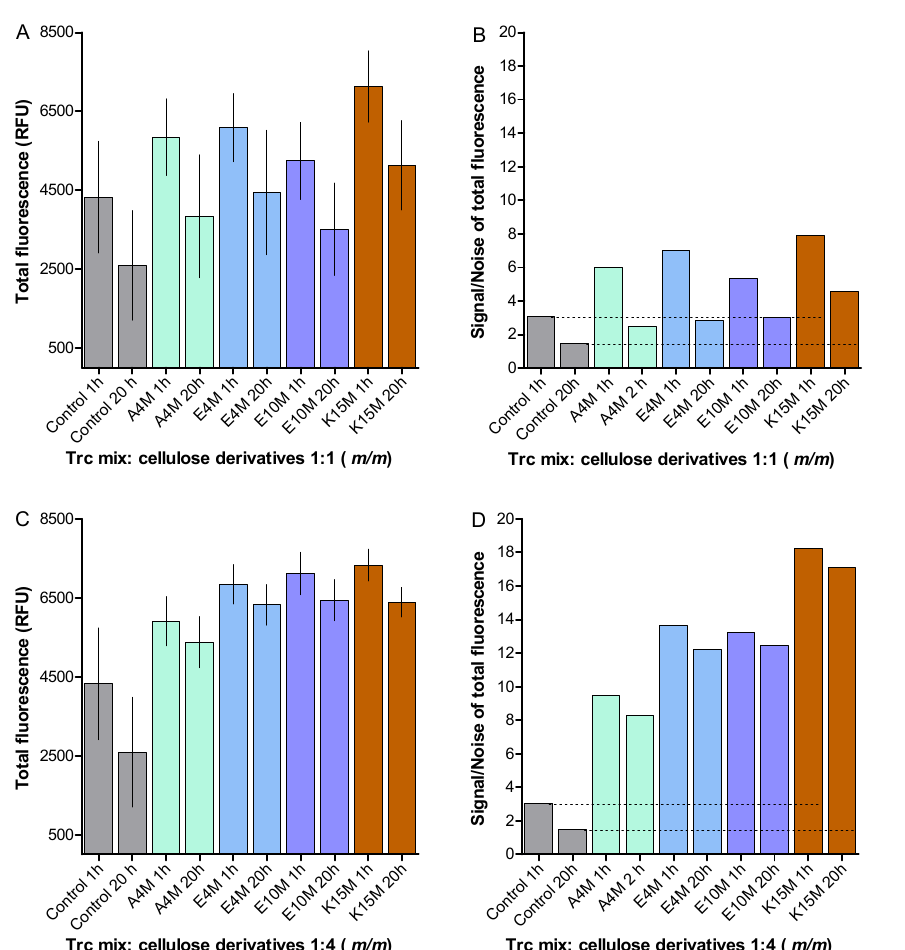
Figure 7. Comparison of the total fluorescence of the formulated Trc mix at 50 µg/mL and different ratios of cellulose derivatives at 1 h and after 20 h, showing the formulations with 1:1 (m/m) ratio ( A ), and those with 1:4 (m/m) ratio ( C ). Each bar represents the mean of 12 preparations and their determinations with SD. The S/N comparison of the respected datasets is shown in ( B ) and ( D ). The dotted lines show the comparison with the controls at 1 h and 20 h.